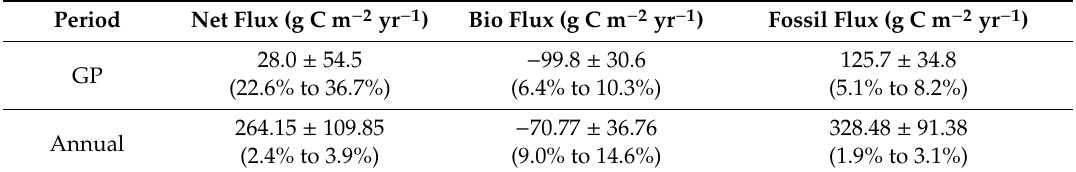
Table 3. Comparison of the estimated carbon uptake increase (6.36 to 10.30 g C m − 2 ) due to greening with various posterior CO 2 fluxes inferred from CT 2017 for the region during the growing period (GP) and the whole year. Posterior CO 2 fluxes include the net flux, biosphere (Bio) flux, and fossil fuel emissions of annual mean and inter-annual variation. Negative values indicate carbon uptake and positive values indicate carbon emission. Values in parentheses compare the CO 2 sink enhancement as percentages of the various GP CT CO 2